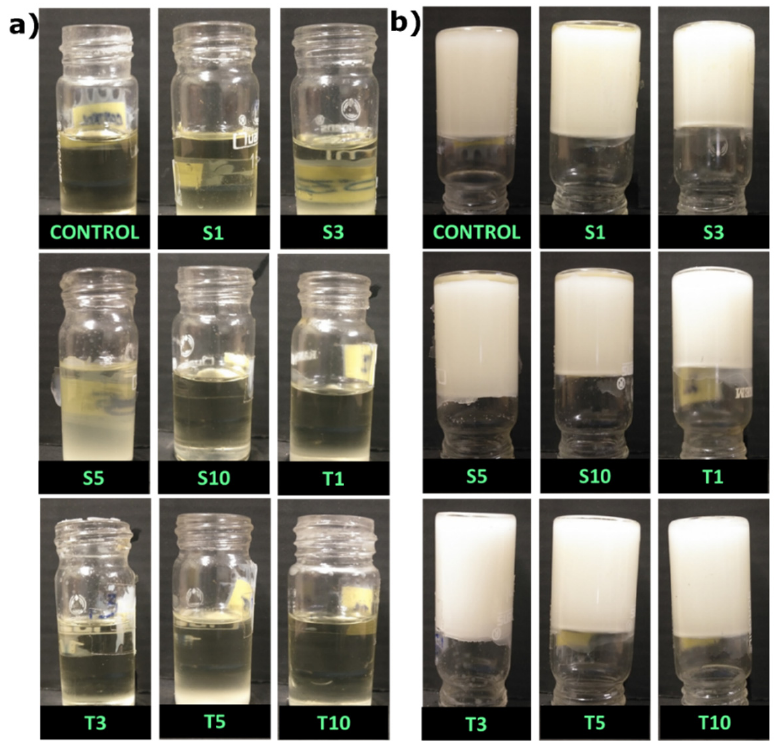
Figure 1. ( a ) Homogenous mixture of formulations; ( b ) inverted tube method. [S1, S3, S5 and S10: 1, 3, 5 and 10 mg of SPAN-80 in oleogels of SO containing 5% ( w / w ) of SFW; T1, T3, T5 and T10: 1, 3, 5 and 10 mg of TWEEN-80 in oleogels of SO containing 5% ( w / w ) of